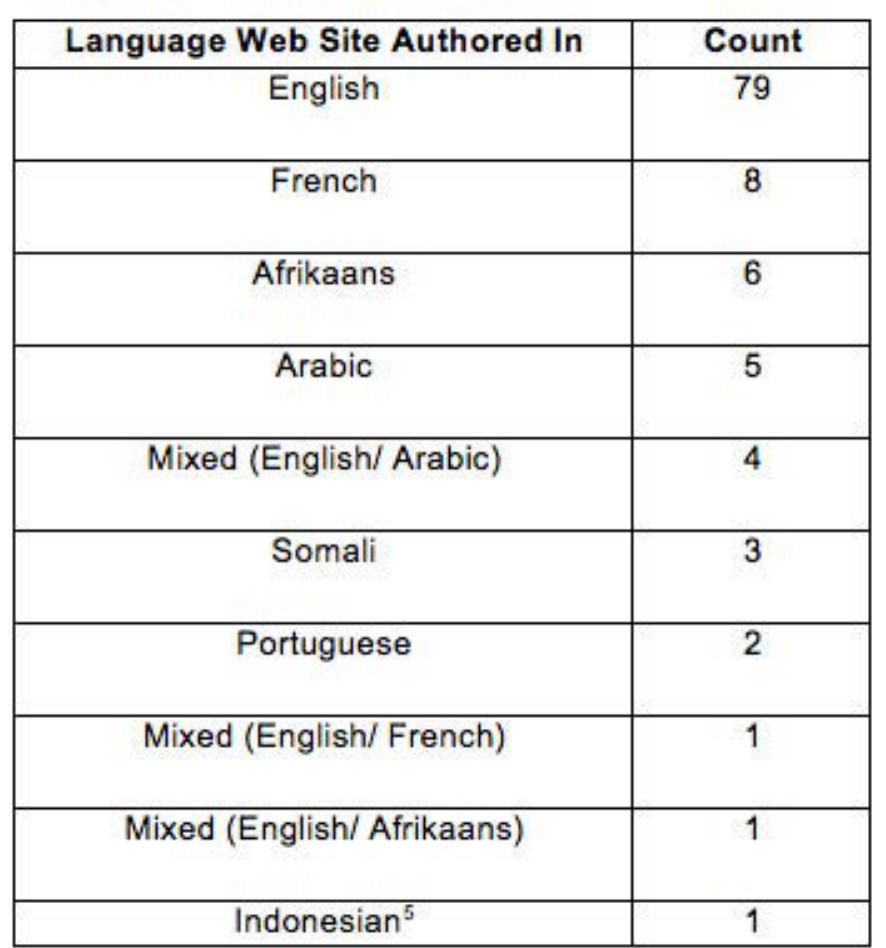
Figure 2: Count of web site publishing